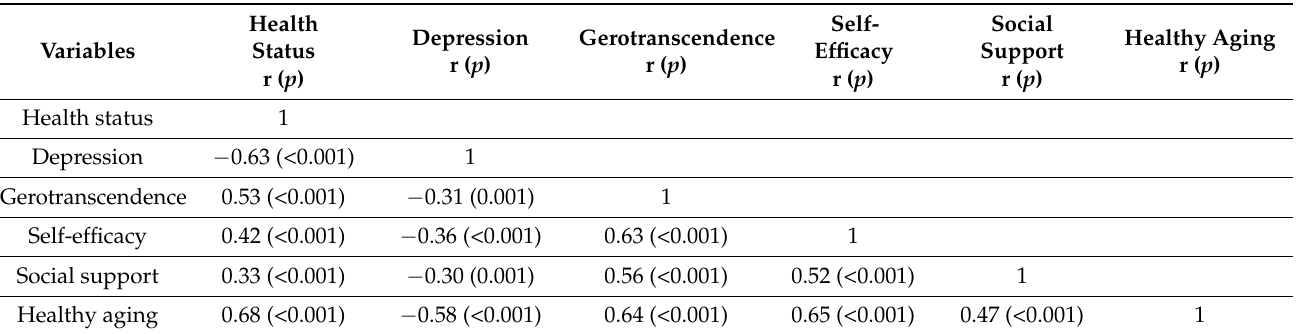
Table 3. Relationships between health status, depression, gerotranscendence, self-efficacy, social support, and healthy aging of